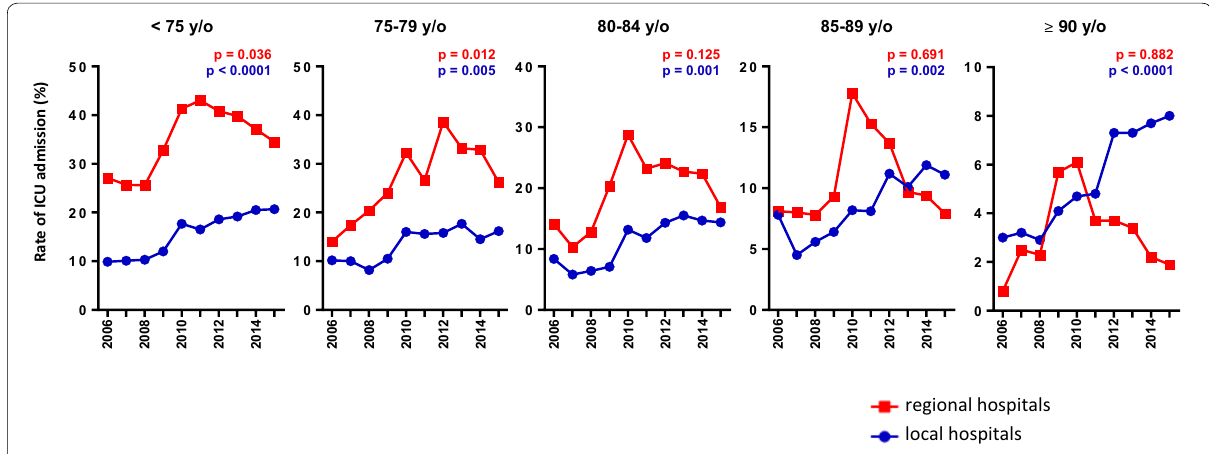
Fig. 6 Ten‑year trends in rate of ICU admission for ARI by age class according to healthcare structures. The rate of ICU hospitalisation refers to percentage of ICU hospitalisations among all hospitalisations for ARI. ARI acute respiratory infections, ICU intensive care